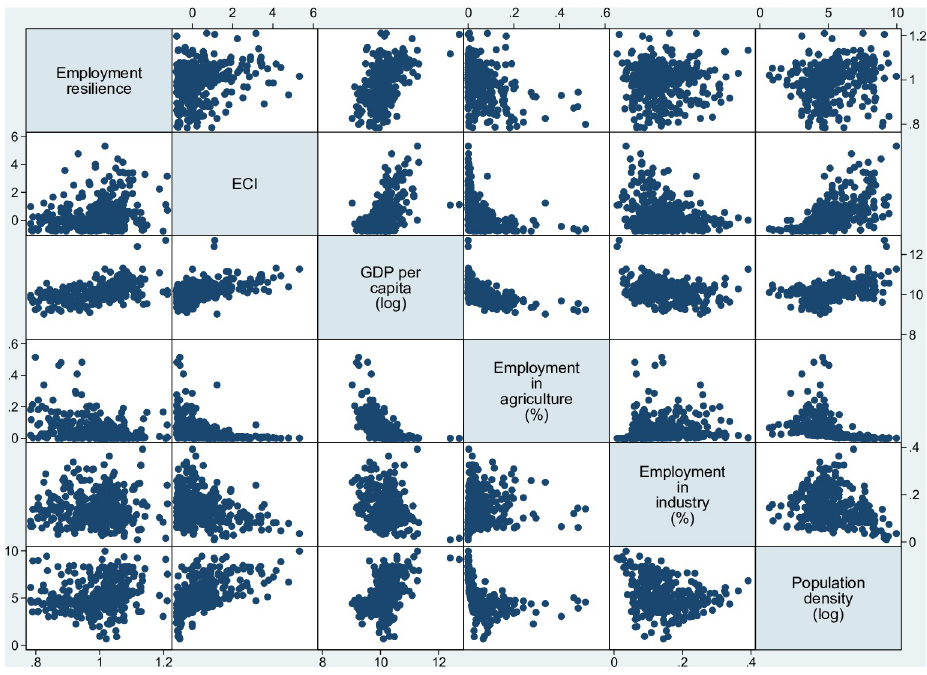
Fig 12. Correlation matrix. The figure has been generated using StataSE